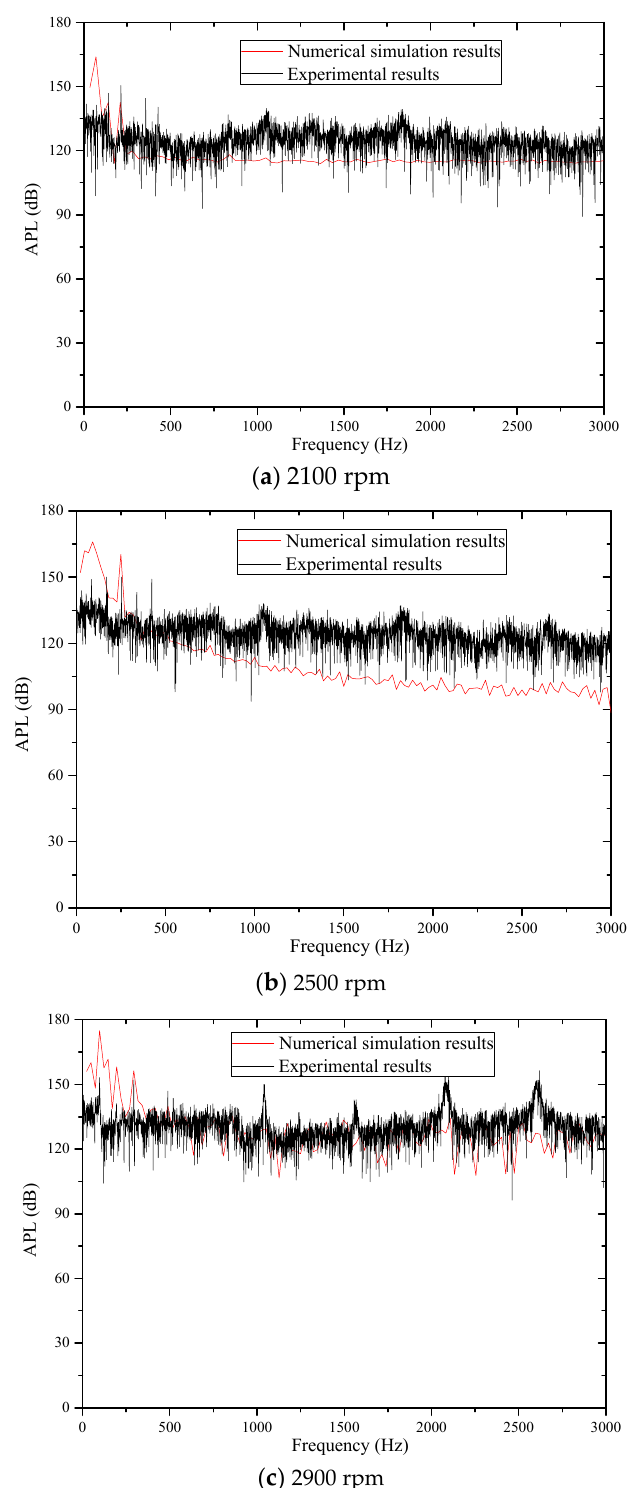
Figure 5. The Acoustic Pressure Level (APL) distribution characteristics obtained by experiment and simulation.